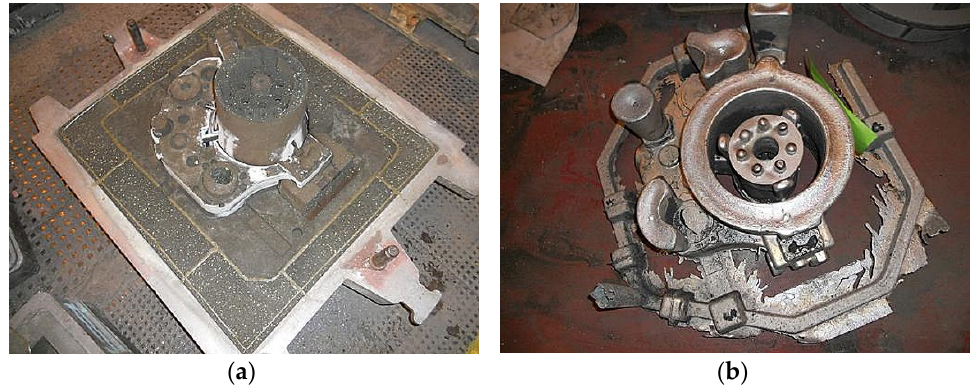
Figure 2. ( a ) Casting mold during assembly; ( b ) engine body sand casting with the gating system.